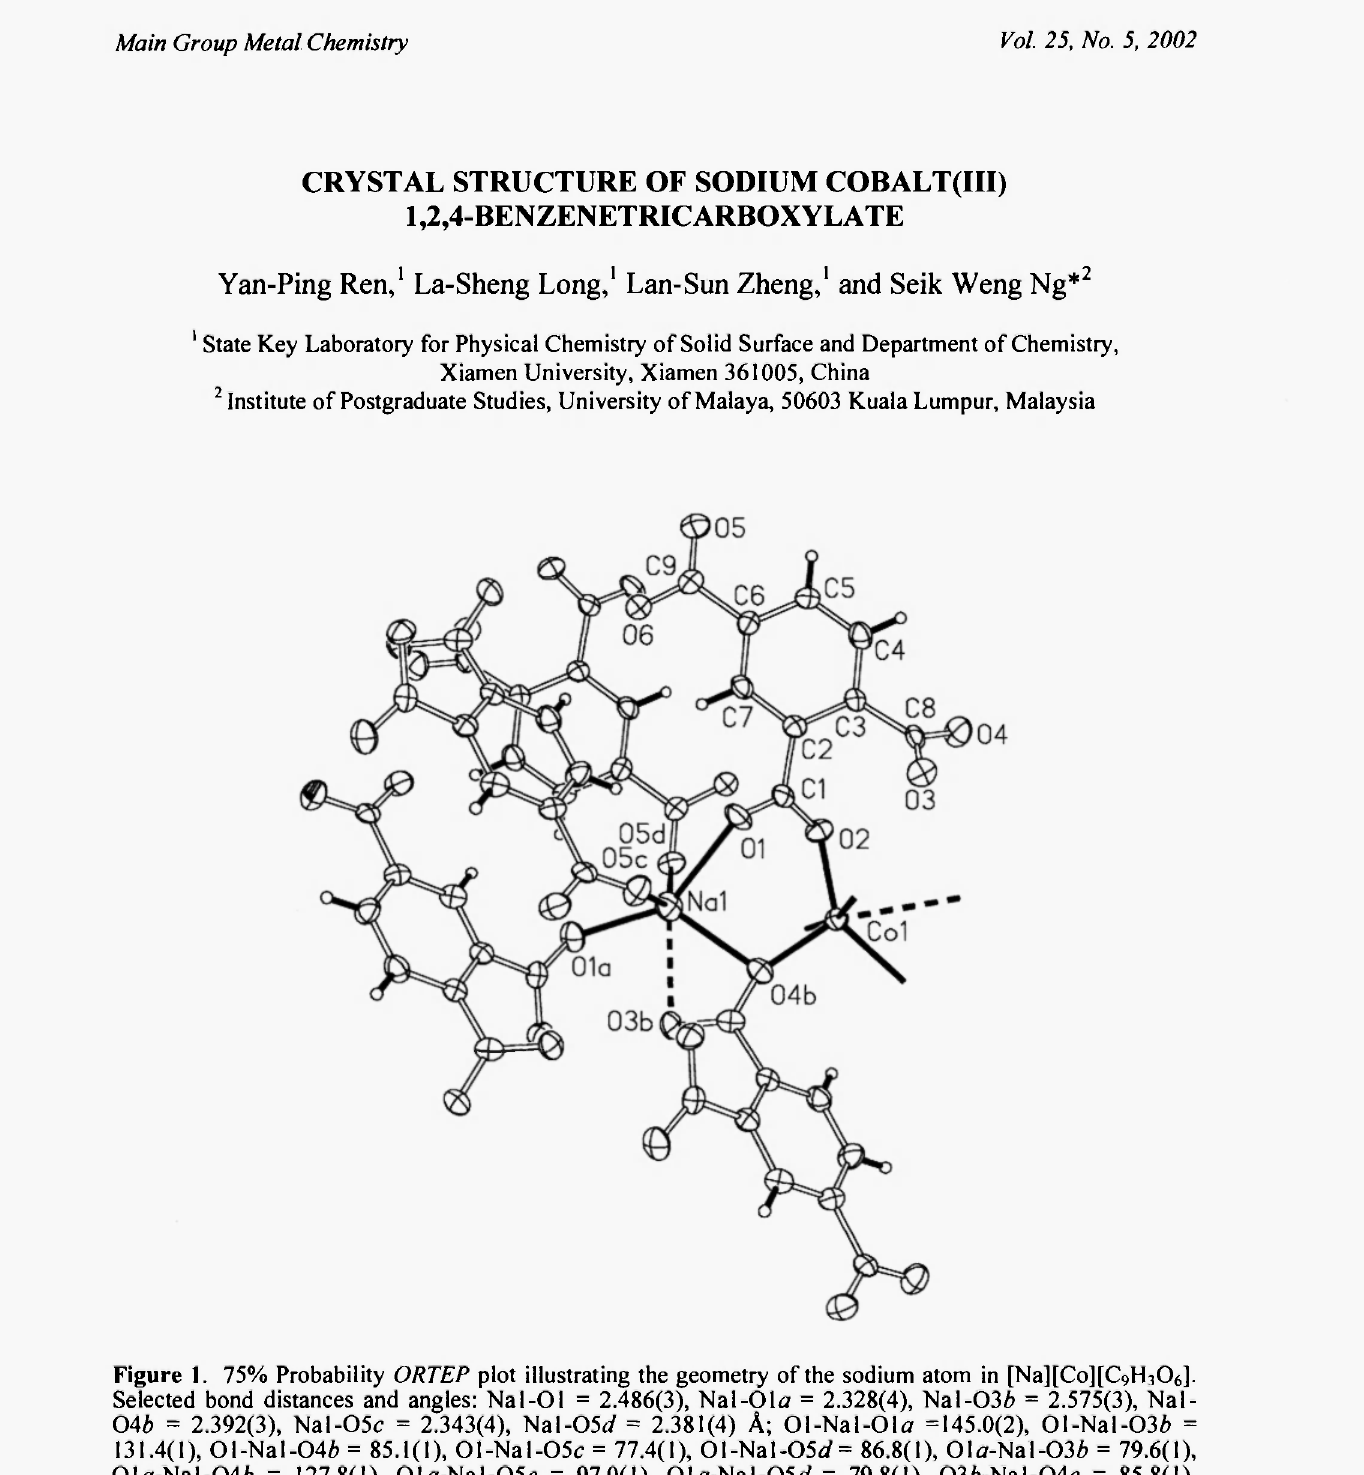
Figure 1. 75% Probability ORTEP plot illustrating the geometry of the sodium atom in [Na][Co][C 9 Hi06]. Selected bond distances and angles: Nal-Ol = 2.486(3), Nal-ΟΙα = 2.328(4), Nal-036 = 2.575(3), Nal- 04b = 2.392(3), Nal-05c = 2.343(4), Nal-05</ = 2.381(4) Ä; Ol-Nal-Ola =145.0(2), 01-Nal-036 = 131.4(1), Ol-Na 1-046 = 85.1(1), 01-Nal-05c = 77.4(1), 01 -Na 1 -05d = 86.8(1), 01a-Nal-036 = 79.6(1), 01a-Nal-04A = 127.8(1), 01a-Nal-05c = 97.0(1), 01a-Nal-05i/ = 79.8(1), 036-Nal-04c = 85.8(1), 036-Nal-05</ = 126.7(1), 036-Nal-056 = 52.4(1), 04A-Nal-05c = 98.4(1), 046-Nal-05i/ = 110.9(1), 05c-Nal-05i/ = 145.3(2)°. Symmetry transformations used to generate equivalent atoms: a = χ - 1/2, 3/2 -y, z;b = 3/2 -x,\/2 +y, 1 - z; c = 3/2 -x, 1/2 +y, -z-,d=\ -χ, 1 -y, -z.